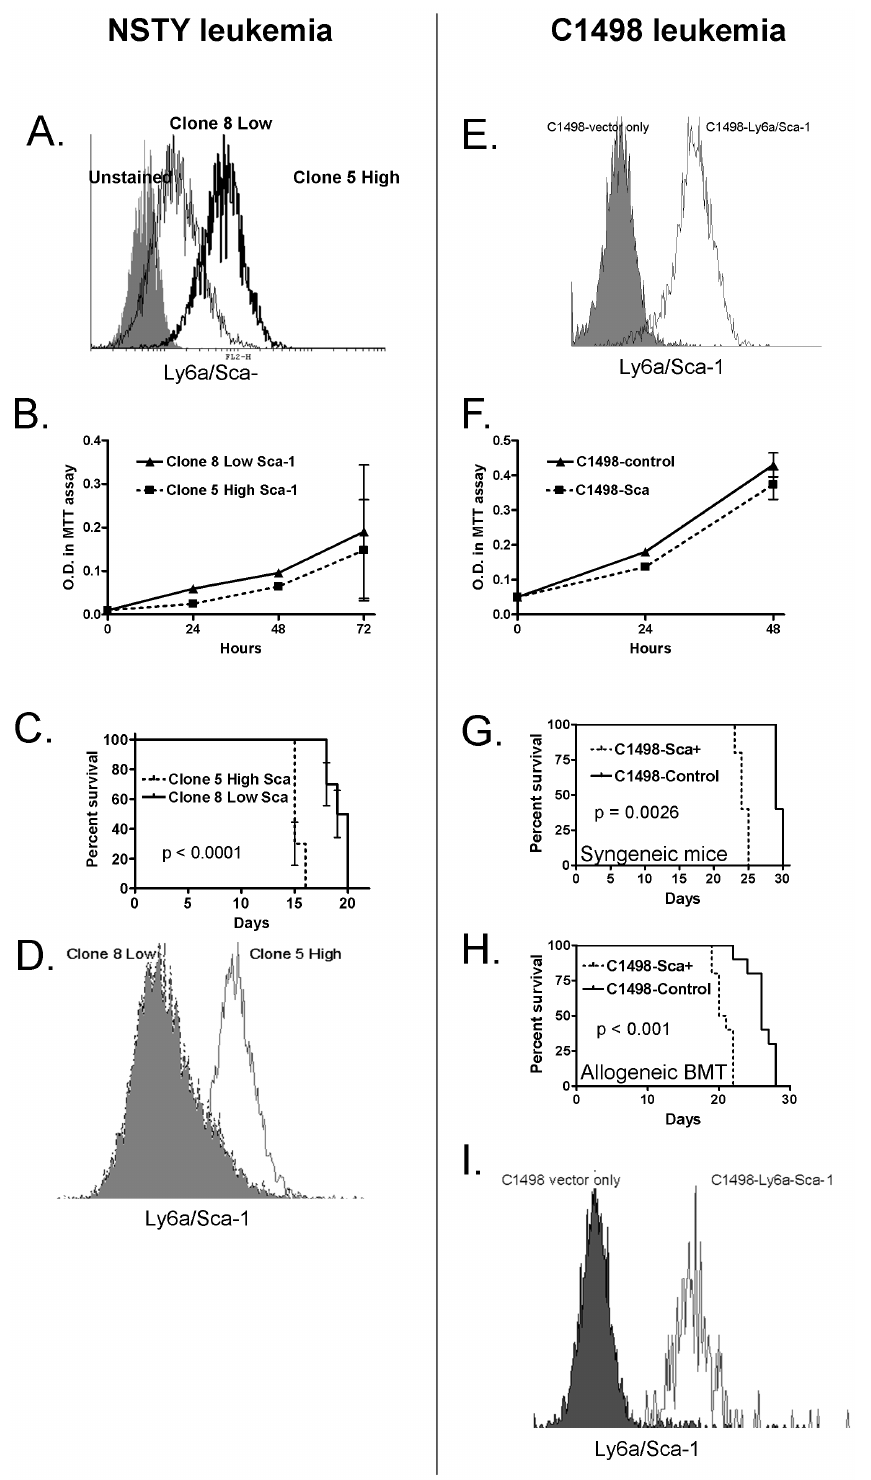
Figure 1. Leukemia cells expressing higher levels of Ly6a/Sca-1 grow more aggressively in vivo and lead to earlier death. Panels A – D depict experiments with NSTY, while panels E – I represent C1498. NSTY. (A) Flow cytometry for Ly6a/Sca-1 expression in clones 5 and 8 at the time of challenge. (B) In vitro growth of NSTY leukemia clones measured in MTT assays. Wells were plated in triplicate. Error bars represent standard deviation. P0.72 by t test. (C) NSTY-clone 5 which expresses high levels of Ly6a/Sca-1 grows more aggressively in vivo in syngeneic mice. Survival curves are presented. N=10 per group. Animals challenged with NSTY clone 5 with high levels of L6a/Sca-1 expression had significantly shorter survival (p , 0.001 by logrank test). (D) Ly6a/Sca-1 expression on NSTY clonal leukemias reisolated from mice in vivo. At time of euthanasia marrow samples were collected from mice and analyzed by flow cytometry for Ly6a/Sca-1 expression. Cells were gated on the leukemia blast population as defined by forward scatter and GFP expression. The filled histogram is the NSTY clone 8 low Ly6a/Sca-1 leukemia while the unfilled histogram is the